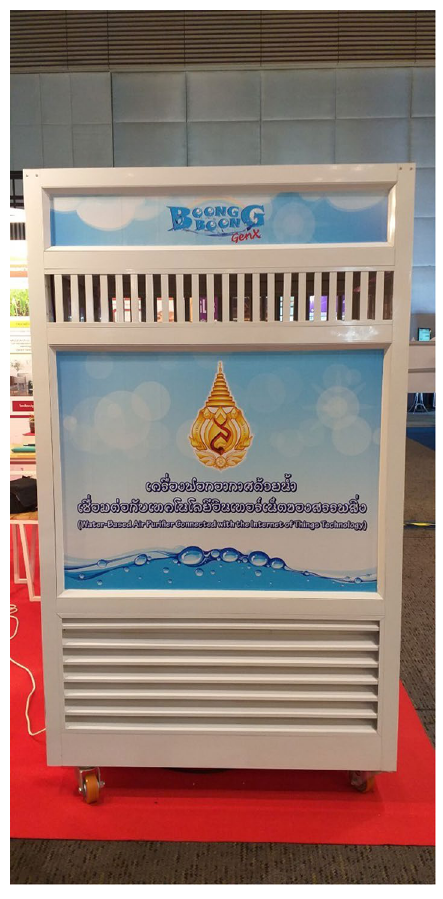
Fig. 2 Water-based air purifier prototype